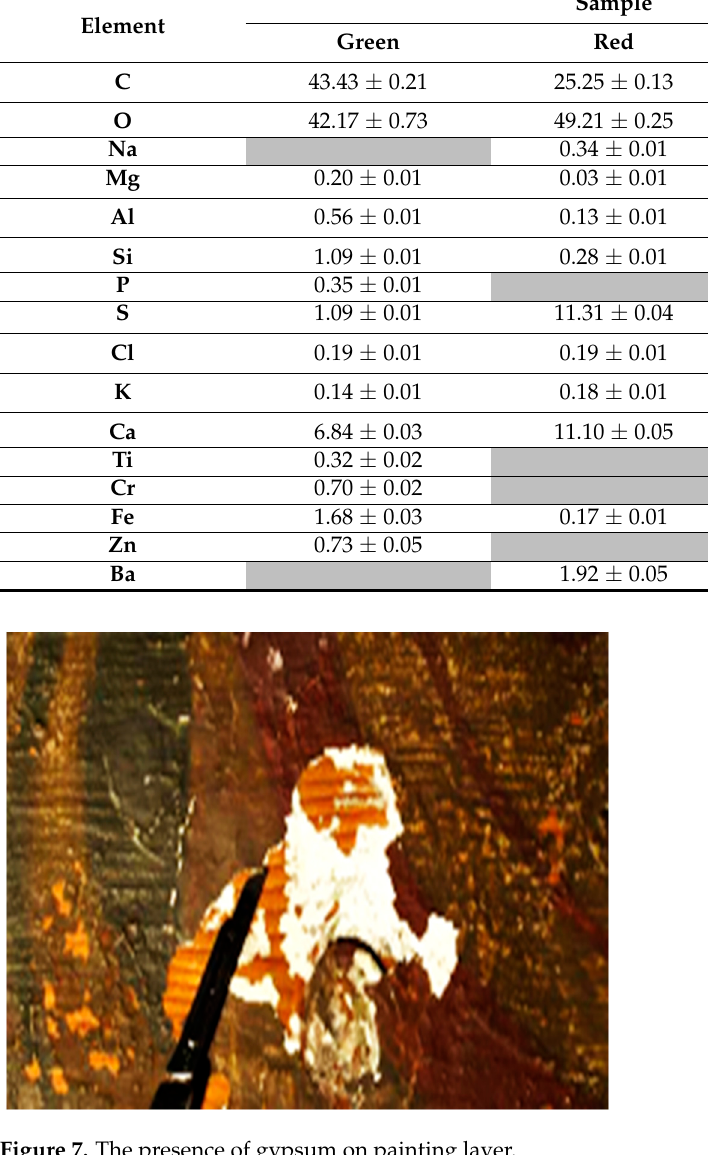
Figure 7. The presence of gypsum on painting layer